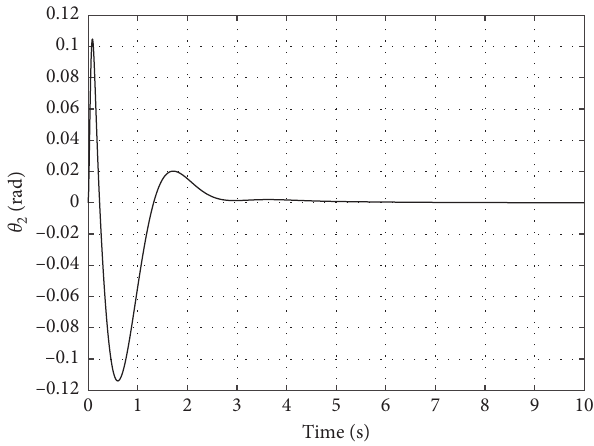
Figure 3: 2 angle simulation curves of the pendulum